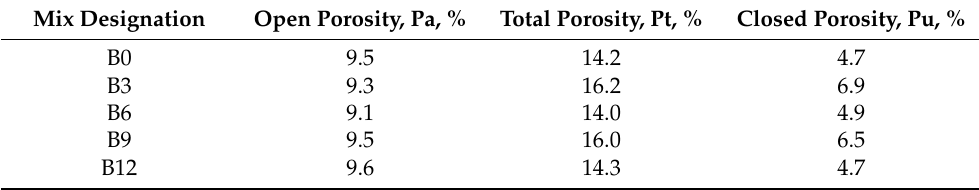
Table 7. Concrete porosity